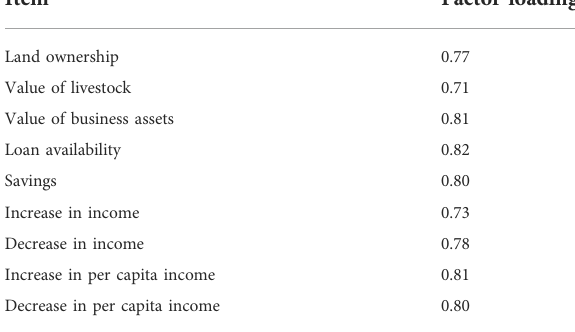
TABLE 2 Cronbach ’ s alpha value of an individual